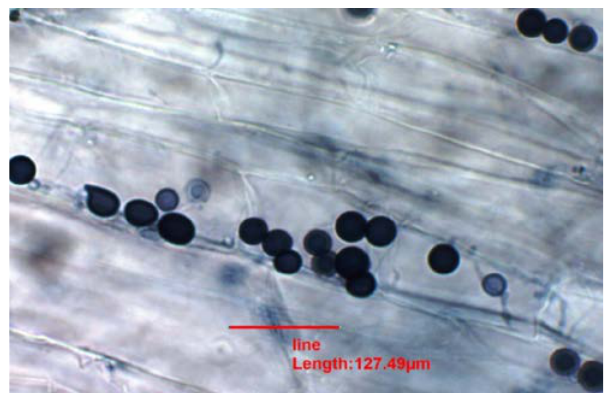
Fig. 2. A hand-cut section of cucumber roots stained with trypan blue showing the intracellular chlamydospores of P. indica within root cortex cells of 14 day-old plants. Likewise, in 28 day-old plants